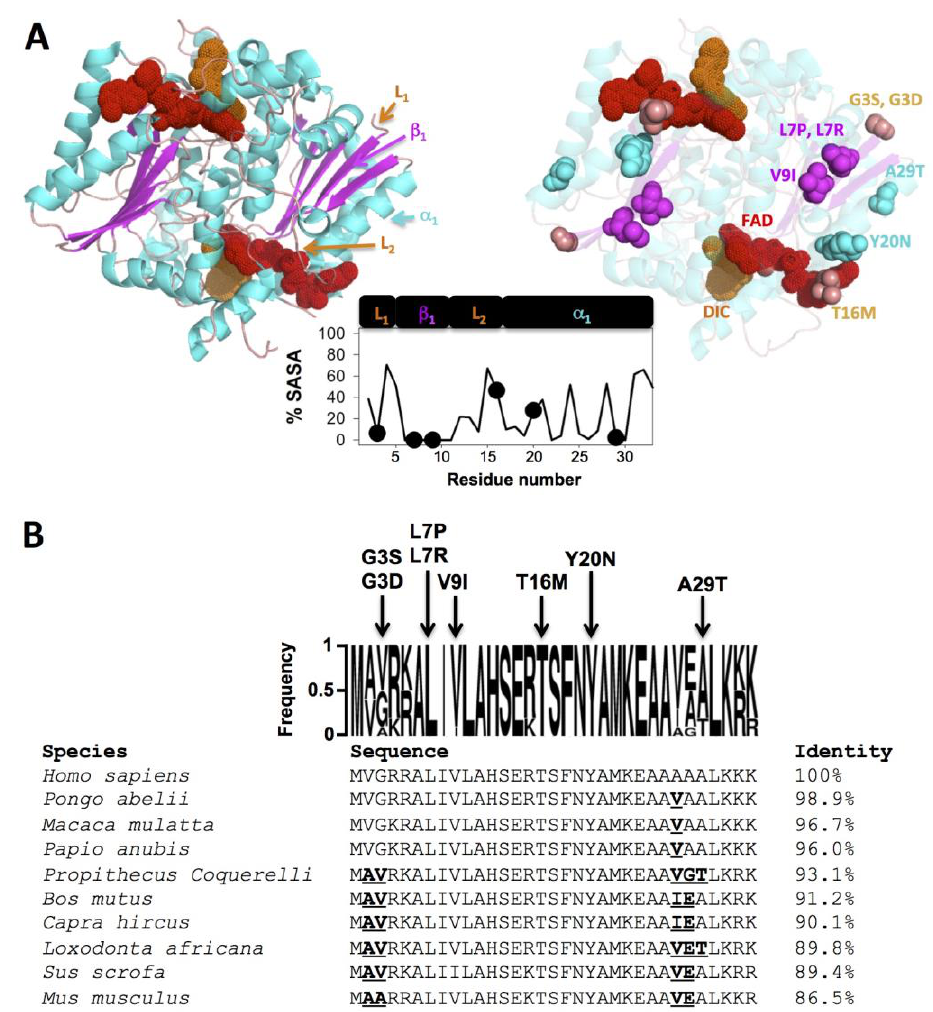
Figure 1. Structural location and sequence conservation of the NQO1 mutations studied in this work. ( A ) Structural representation on the dimeric structure of NQO1 (PDB code 2F1O; [72]). The left panel shows the secondary structure elements to which mutated residues belong (L 1 , residues 1–4; β 1 , residues 5–10; L 2 , residues 11–16 and 1 , residues 17–33). The right panel shows the location of the mutated residues as well as the FAD and dicoumarol (Dic) molecules. Residues are colored according to the secondary structure. The plot in the middle shows the solvent accessibility (% SASA) of this region (determined using GETAREA on the PDB code 2F1O as the average of the two monomers in the dimer). ( B ) Sequence alignment of 10 selected NQO1 mammalian proteins. Residues in bold-underlined indicate non-conservative mutations vs. the human sequence (note that K-to-R or V-to-I are considered as conservative ). The frequency plot over the NQO1 alignment (generated using WebLogo, https: // weblogo.berkeley.edu / ) also shows the identity of the missense mutations investigated in this